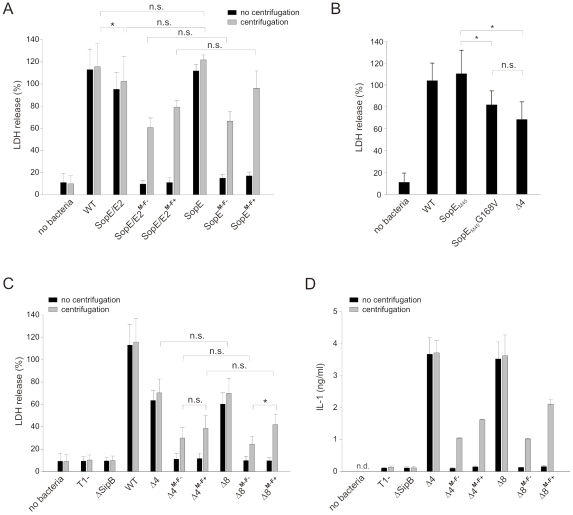
SopE and an intact T1 system contribute to flagellin-independent caspase-1 activation.
A) SopE is the main effector protein mediating caspase-1 activation in the absence of flagellin. LDH release induced by strains expressing SopE and SopE2 (ΔsipA ΔsopB; SopE/E2, SopE/E2M−F−, and SopE/E2M−F+) is equivalent to LDH release induced by strains additionally lacking SopE2 (ΔsipA ΔsopB ΔsopE2; SopE/E2, SopE/E2M−F−, and SopE/E2M−F+). Note that data shown in A) and C) were obtained from the same experiments. The value for WT in A) was replotted in C) for better comparison. B). The catalytic activity of SopE (infection with SopEM45 strain) is required for full LDH release. A strain with a catalytically inactive SopE mutant (SopEM45G168V; ΔsipA ΔsopB ΔsopE2) induces the same level of LDH release as a mutant lacking four effector proteins including SopE (Δ4; ΔsipA ΔsopB ΔsopE ΔsopE2). C) Mutants lacking four (Δ4; ΔsipA ΔsopB ΔsopE ΔsopE2) or eight (Δ8; ΔsipA ΔsopB ΔsopE ΔsopE2 ΔsopA ΔsptP ΔspvB ΔspvC) virulence proteins induce LDH release with (Δ4M−F+, Δ8M−F+) or without flagellin (Δ4M−F−, Δ8M−F−), whereas a sipB mutant that lacks the ability for translocon insertion does not. D) IL-1 maturation induced by Δ4, Δ8, Δ4M−F+, Δ8M−F+, Δ4M−F−, and Δ8M−F−. n.d.: not detected. Mean +/− standard deviation of triplicates from at least 2 independent experiments. n.s.: not significant; *: p-value ≤0.05 (paired t-test in panel B; Mann-Whitney U test in panel C). Data shown in D) are representative of 3 independent experiments.